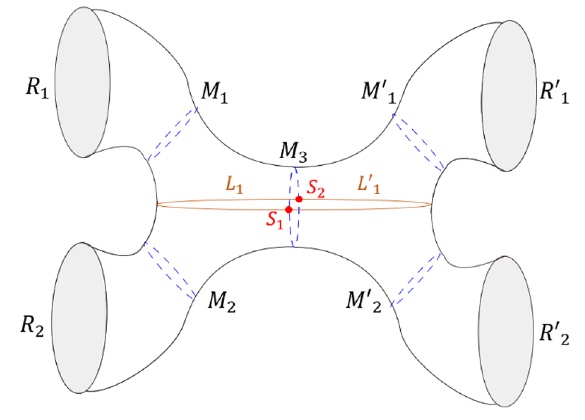
Figure 2 . The purified geometry is a 4-side wormhole which is symmetric with respect to the horizon M 3 . The brown geodesic L 1 ∪ L 0 intersects M 3 at two points s 1 and s 2 . The minimal cross 1 section can be obtained by minimizing the length of L 1 ∪ L 0 or equivalently, L 1 , over s 1 and s 2 1